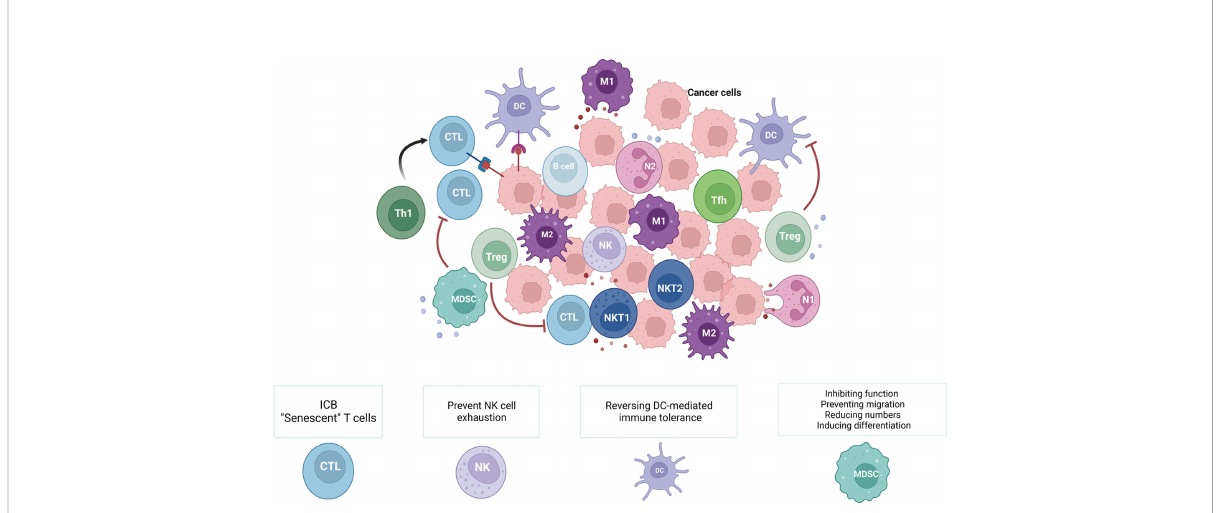
FIGURE 1 Immune cells within the TIME and related cancer immunotherapies. The TIME consists of various innate immune cells (macrophages, neutrophils, dendritic cells, myeloid-derived suppressor cells, and natural killer cells) and adaptive immune cells (T and B cells). During different stages of tumors and due to the diversity of the TIME, these immune cells have distinct roles in antitumor immunity. Therefore, methods for cancer immunotherapy that target tumor-suppressing immune cells include ‘ exhausted ’ T cells (ICB), ‘ senescent ’ T cells, exhausted NK cells, DC-mediated immunological tolerance, and MDSCs (inhibiting the function of MDSCs, preventing the migration of MDSCs, reducing the number of MDSCs, and inducing the differentiation of MDSCs). (Created with